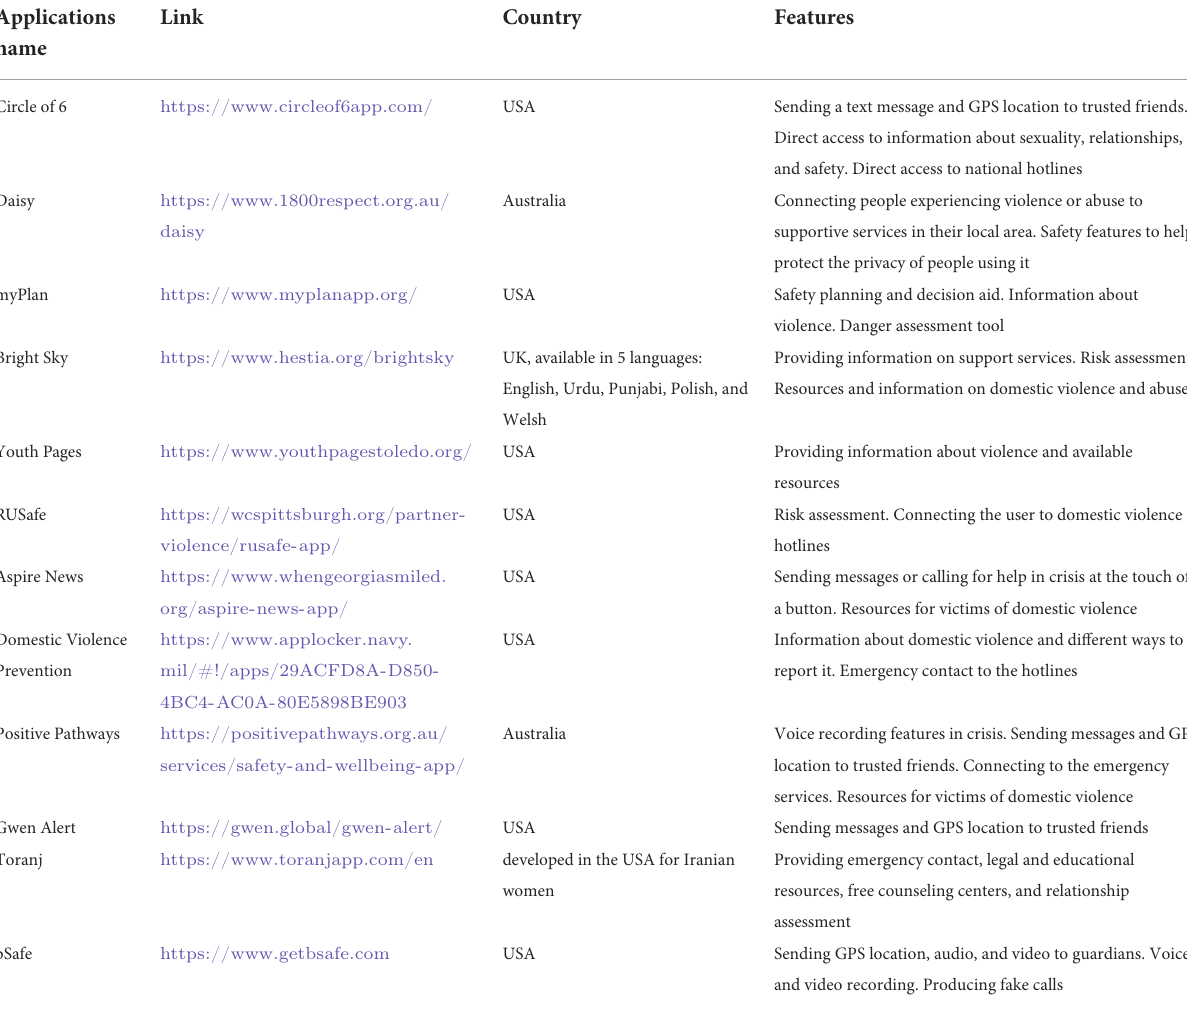
TABLE 1 Reviewing a number of DV-related applications and their features *